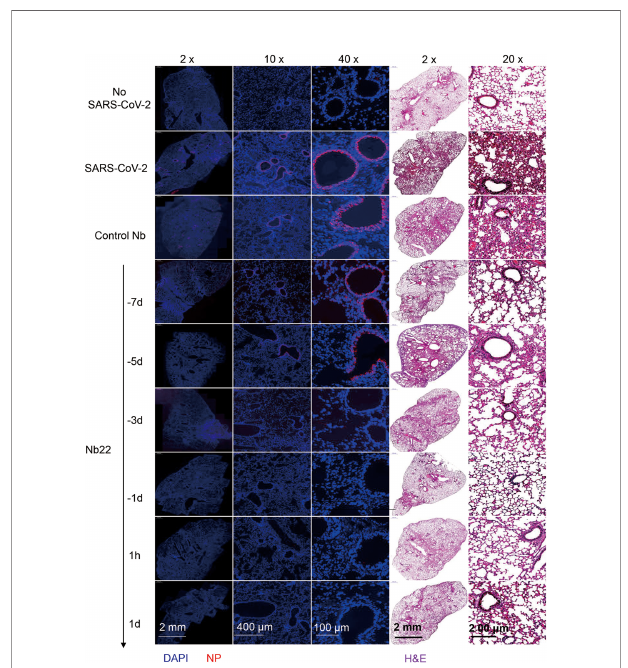
FIGURE 7 | Representative sections of lung from hACE2 mice were analyzed by H&E staining and immuno fl uorescence staining. Representative lung tissue sections from the mice indicated in Figure 6C , namely, No-SARS-CoV-2, SARS-CoV-2, Control Nb, − 7d-Nb22, − 5d-Nb22, − 3d-Nb22, 1h-Nb22, and 1d-Nb22 group were analyzed by immuno fl uorescence staining using antibodies speci fi c to SARS-CoV-2 NP in red and DAPI for nuclei in blue, respectively. The corresponding representative lung tissue sections were also analyzed by H&E staining. Immuno fl uorescence and HE Images were visualized under the indicated